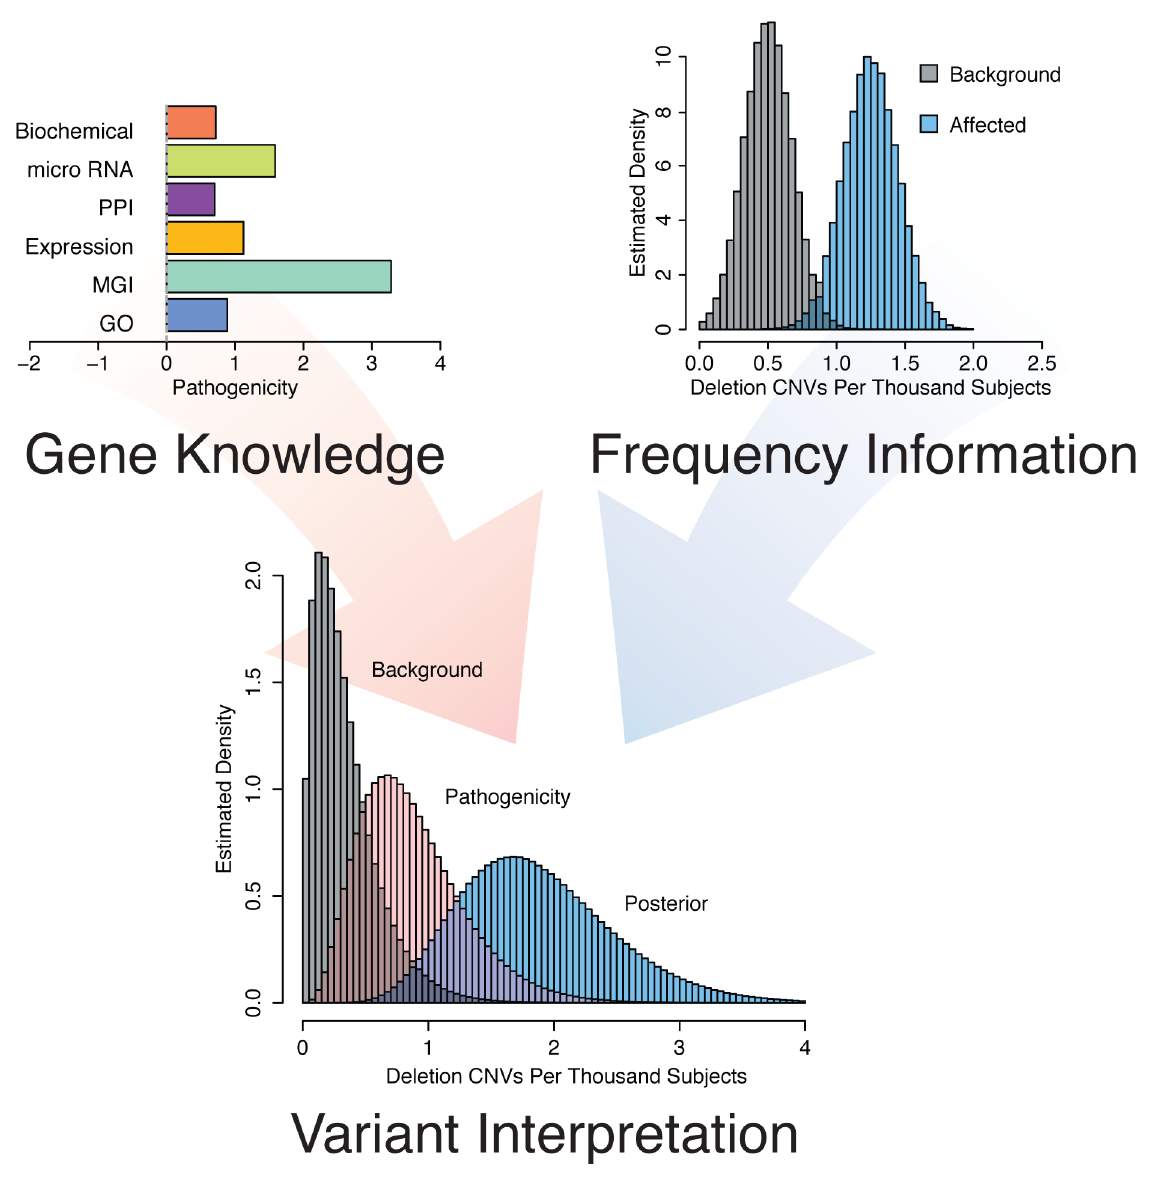
Figure 2. Concept of gene and variant prioritization. Top Left . Phenotype specific knowledge about each individual RefSeq gene is gained by comparing the features of the gene to a set of known ‘‘training genes’’ based on Gene Ontology annotation, knockout mouse phenotypes mapped to human orthologues, tissue expression patterns, protein-protein interactions, micro RNA targeting, and pathway membership information. Top right . Relevance to epilepsy is assessed by comparing the frequency of gene disruption among individuals with epilepsy to the frequency of disruption among a background population. Bottom . These two sources of information, gene knowledge and variant frequency, are combined using Bayesian methods to arrive at a Bayes factor and a posterior rate distribution to prioritize individual genes for phenotypic